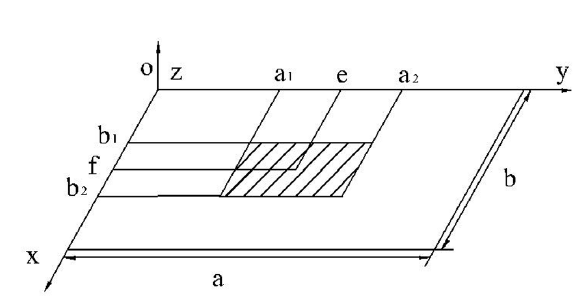
Fig. 2: Geometry configuration of the damaged